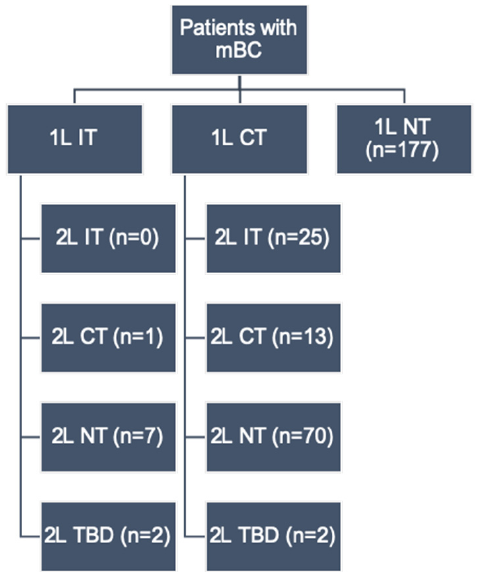
Figure 1. Palliative systemic therapy by line. Abbreviations: mBC = metastatic bladder cancer, 1L = first-line, 2L = second-line, CT = chemotherapy, IT = immunotherapy, NT = no treatment, TBD = to be decided (i.e. patient has not completed 1L therapy or was being considered for 2L therapy at the time of data collection).